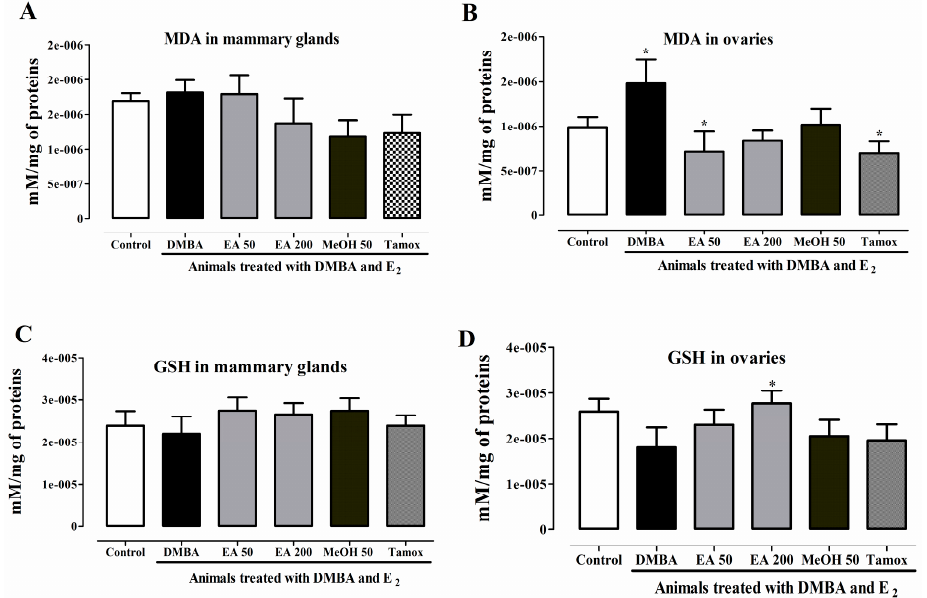
Figure 13. Effects of F. umbellata extracts on MDA and GSH levels in different organs. MDA level in